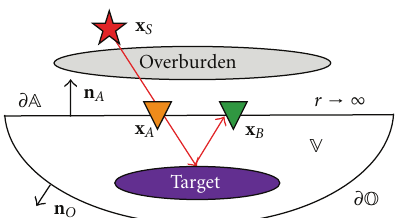
Figure 16: Configuration for controlled-source interferometry by multidimensional deconvolution of decomposed fields; integration volume V is enclosed by receiver array ∂ A and an additional halfsphere ∂ O ; x S denotes a source location; x A and x B denote receiver locations at ∂ A and n A is the unit normal vector of the receiver array; n O is the unit normal vector of ∂ O ; heterogeneities between sources and receivers are referred to as “overburden,” whereas heterogeneities below the receivers are referred to as